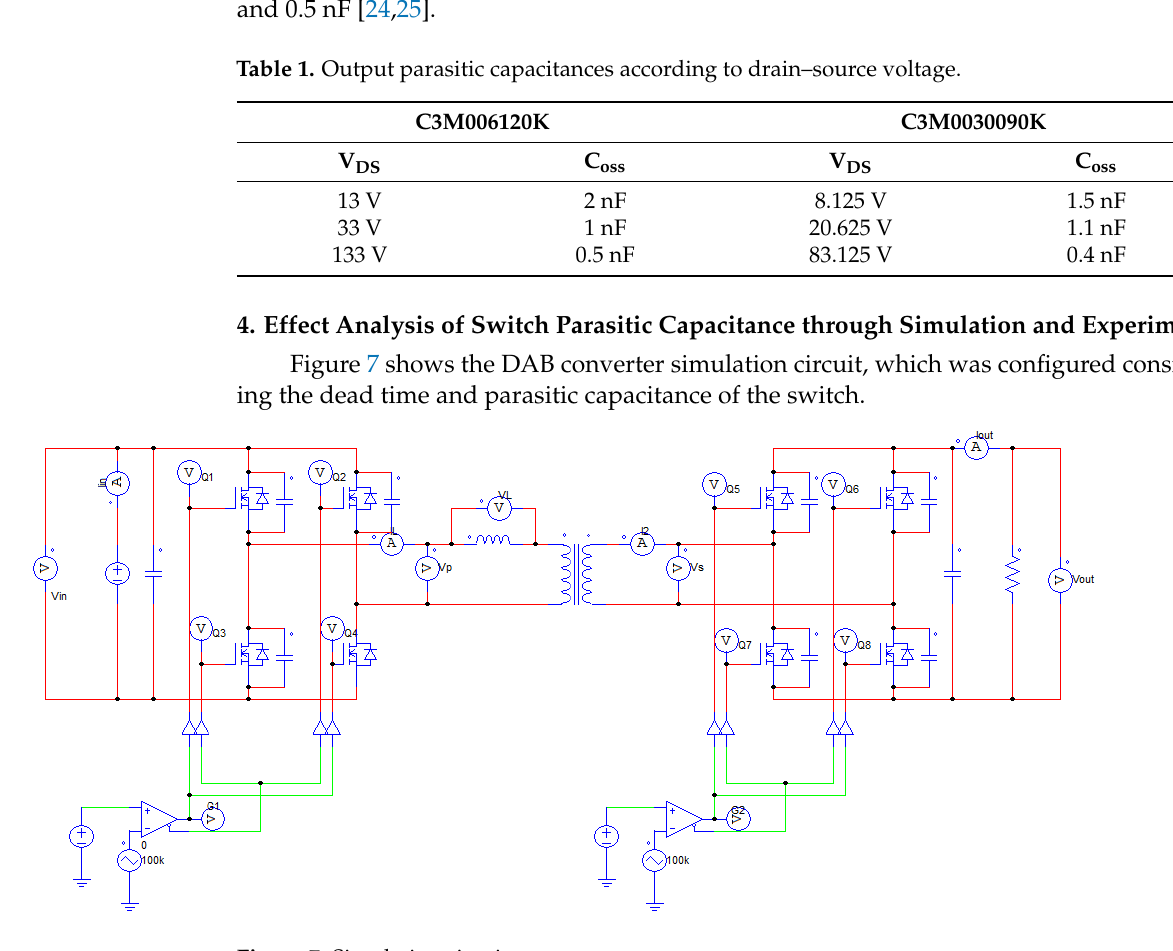
Figure 7. Simulation circuit structure.